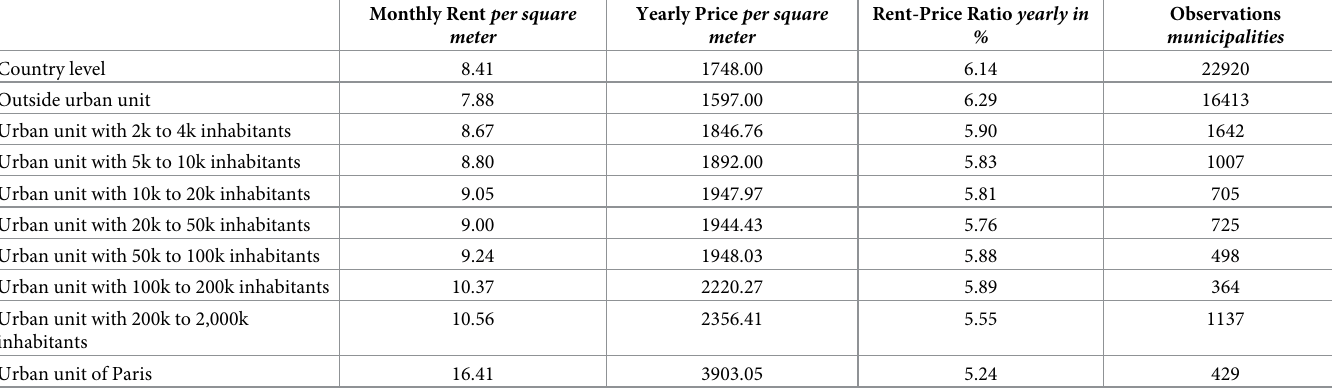
Table 6. Descriptive statistics of the municipal hedonic